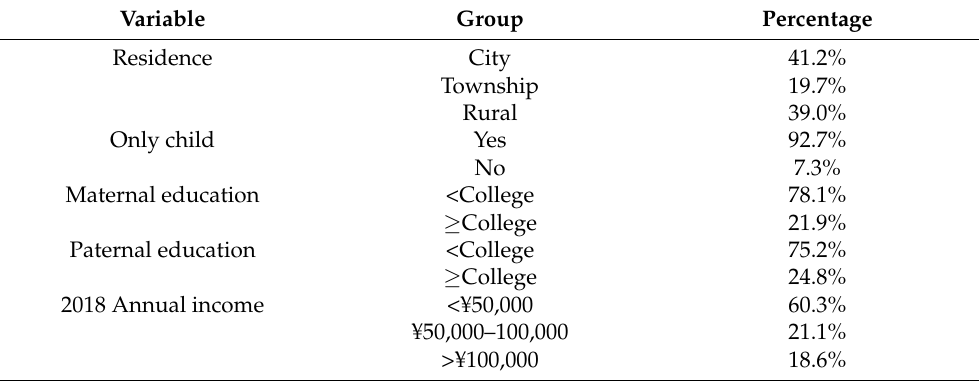
Table 1. Demographic characteristics of